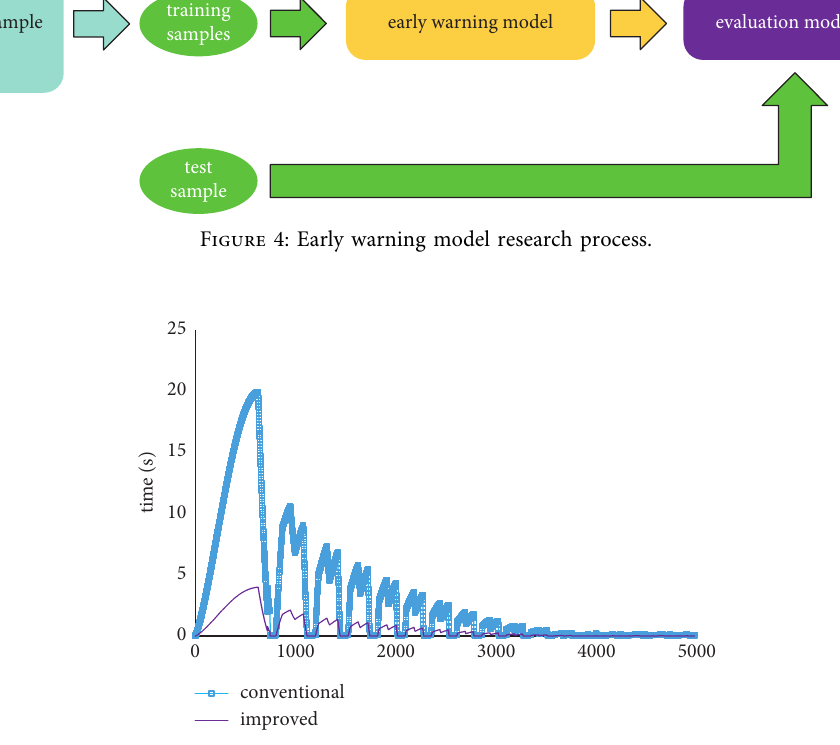
Figure 5: Line chart of the running time of the two algorithms on the financial index